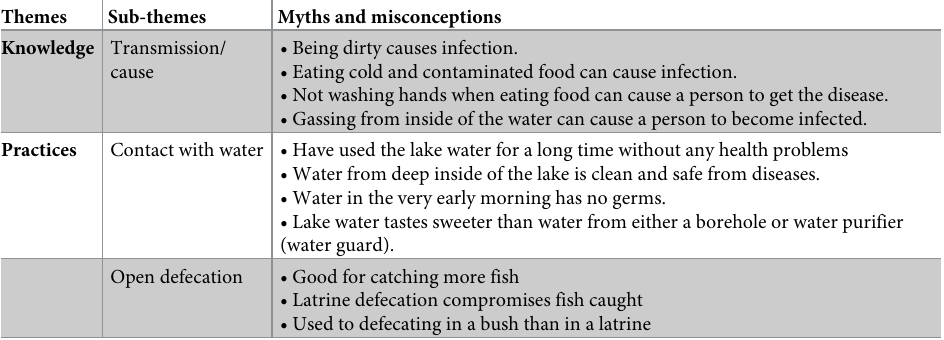
Table 8. Summary of myths and misconceptions surrounding schistosomiasis in western